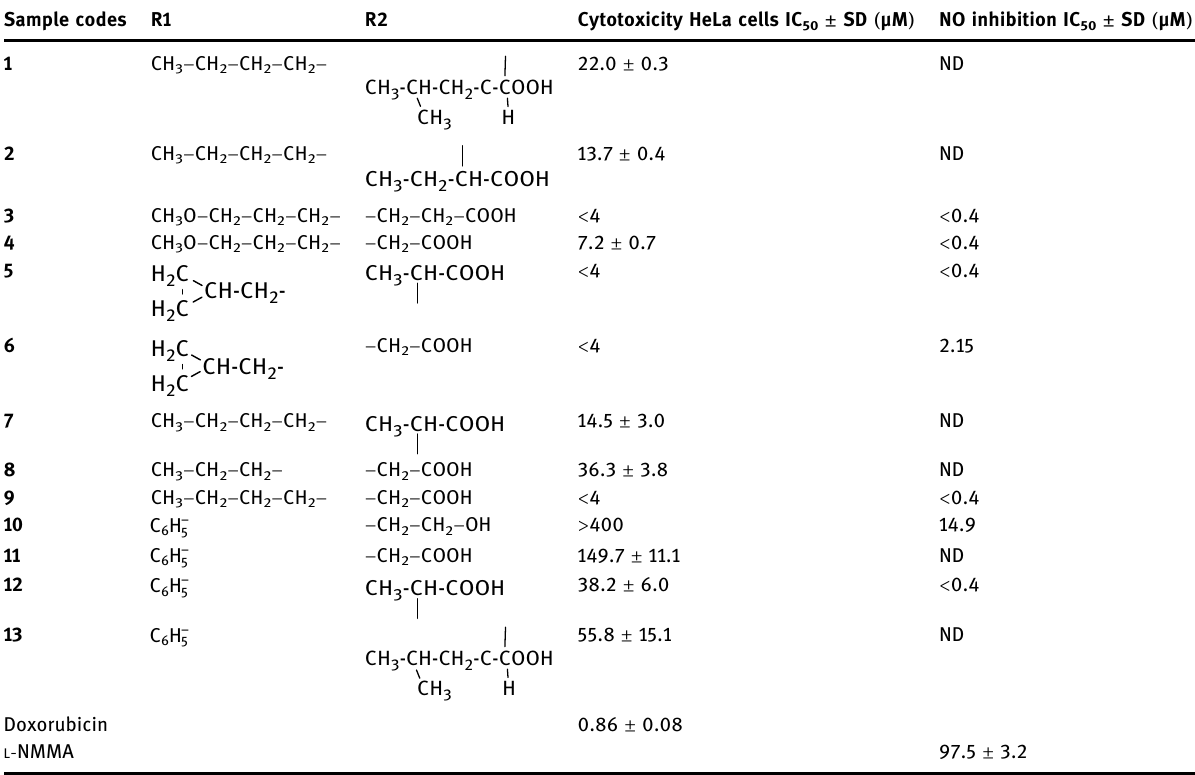
Table 1: Cytotoxic and NO inhibition of tested series